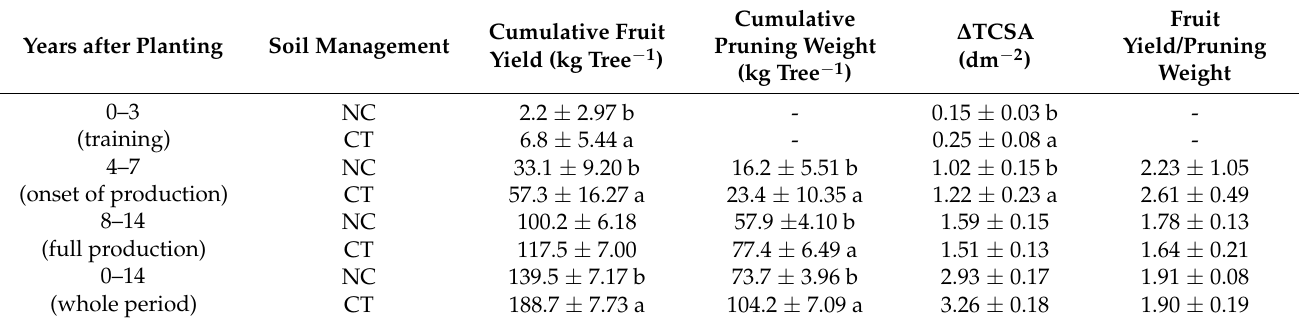
Table 1. Cumulative fruit yield, cumulative pruning weight, TCSA increment and the fruit yield-to-pruning weight ratio of olive trees (cv. Frantoio) subjected to different soil management systems (NC: Natural Cover; CT: Conservative Tillage). Values are the means ± standard errors of nine trees per treatment within each time period. Least significant differences (LSD) were calculated by ANOVA ( p ≤ 0.05).